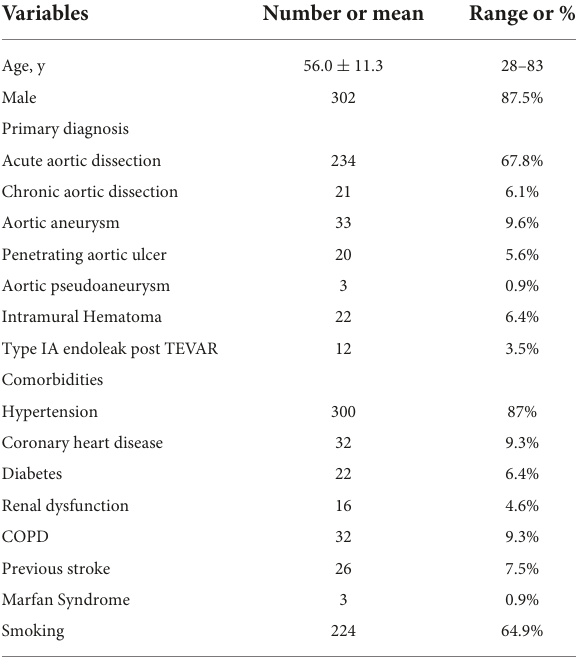
TABLE 1 Baseline characteristics of the